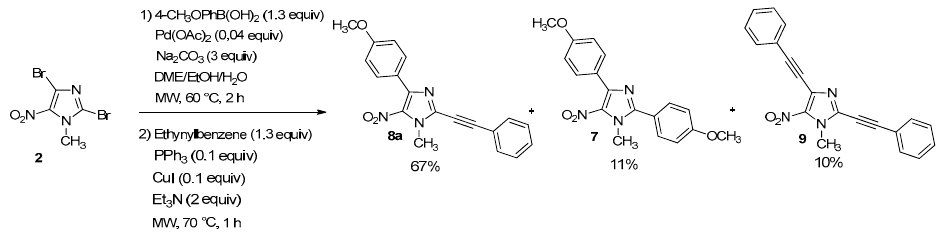
Table 5. Scope of the one-pot Suzuki-Miyaura/Sonogashira reaction. a